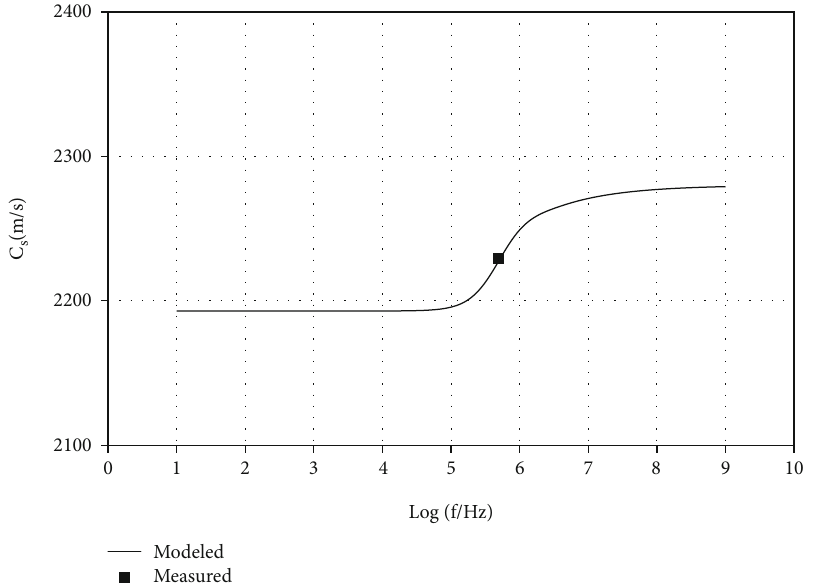
’ Euville limestone under